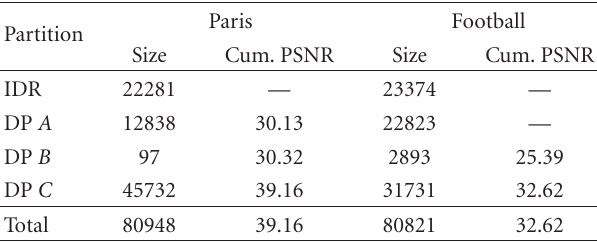
Table 2: Priority class and LT packetization for first GOP of “Paris” sequence.